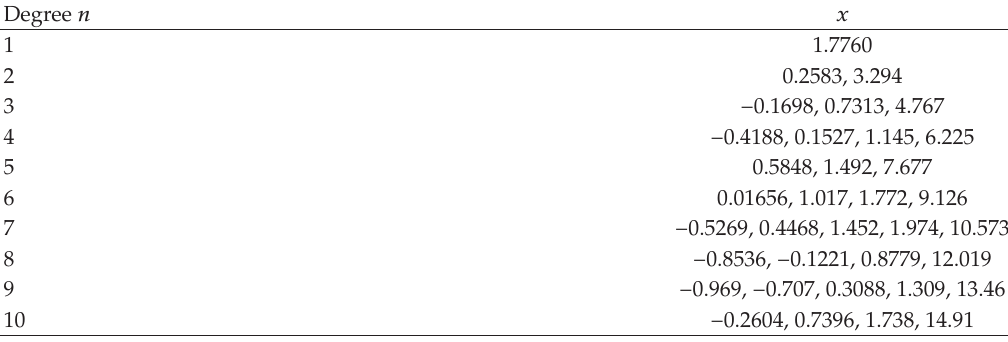
Table 2: Approximate solutions of G n, 1 / 2 (cid:2) x (cid:3) (cid:6) 0 ,x ∈ R .